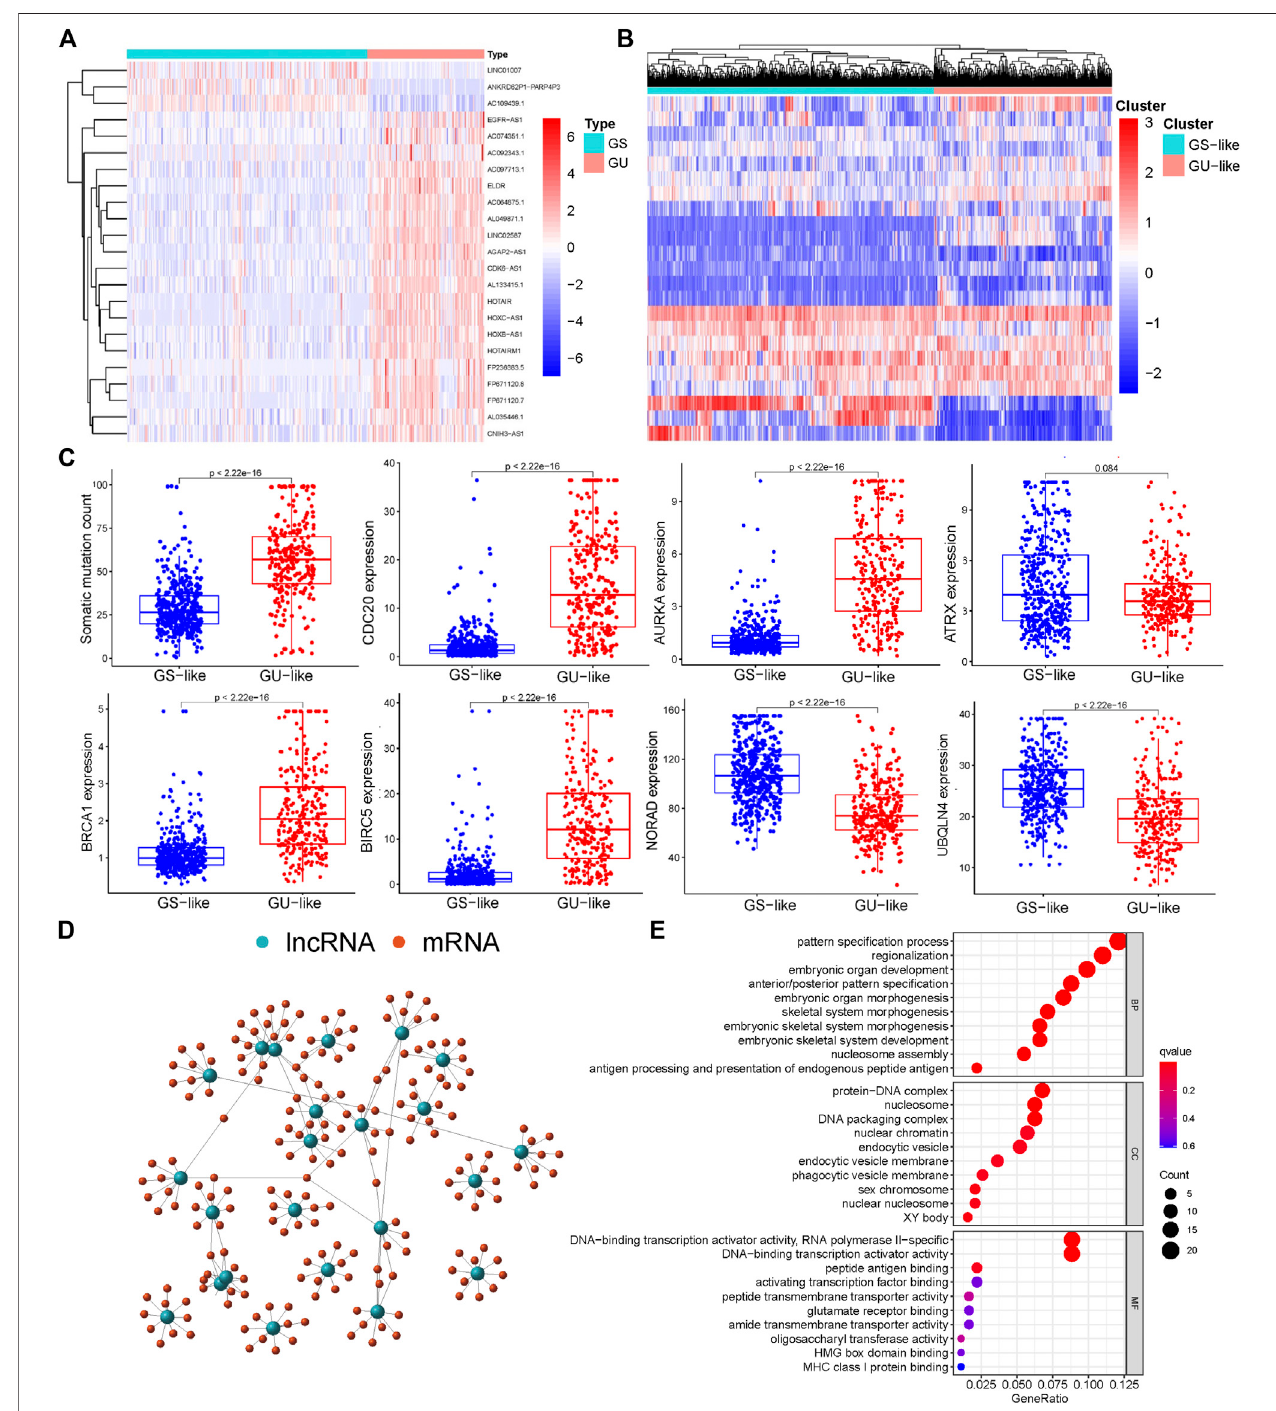
FIGURE 1 | Screening and functional enrichment of genetic instability-related lncRNAs derived from somatic mutations in glioma patients. (A) Heatmap of signi fi cantly different lncRNAs between genome stability and genome instability samples. The left green cluster is the genome stable (GS)-like group, and the right red cluster is the genome unstable (GU)-like group. (B) Unsupervised cluster analysis of 23 lncRNAs related to genome instability in 698 glioma samples. (C) Boxplot of differentialexpressionofsomaticmutations,CDC20,AURKA,ATRX,BRCA1,BIRC5,NORAD,andUBQLN4,inGSandGU. (D) Co-expressionanalysisoflncRNA and miRNA based on the Pearson correlation coef fi cient. (E) Gene ontology (GO) function enrichment analysis of mRNA co-expressed with lncRNA.